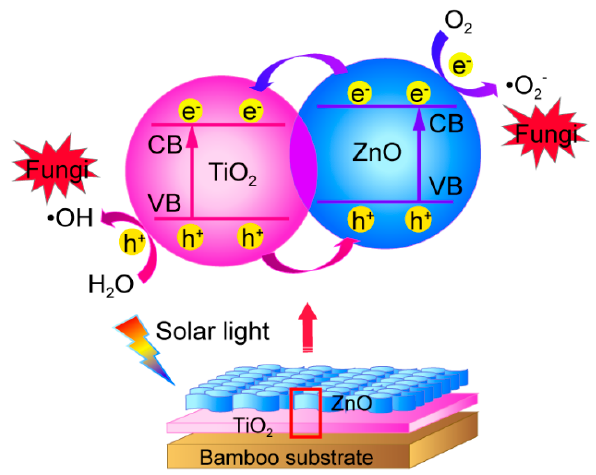
Figure 8. Schematic diagram of the enhanced antifungal property for the ZnO/TiO 2 -B under solar light irradiation.